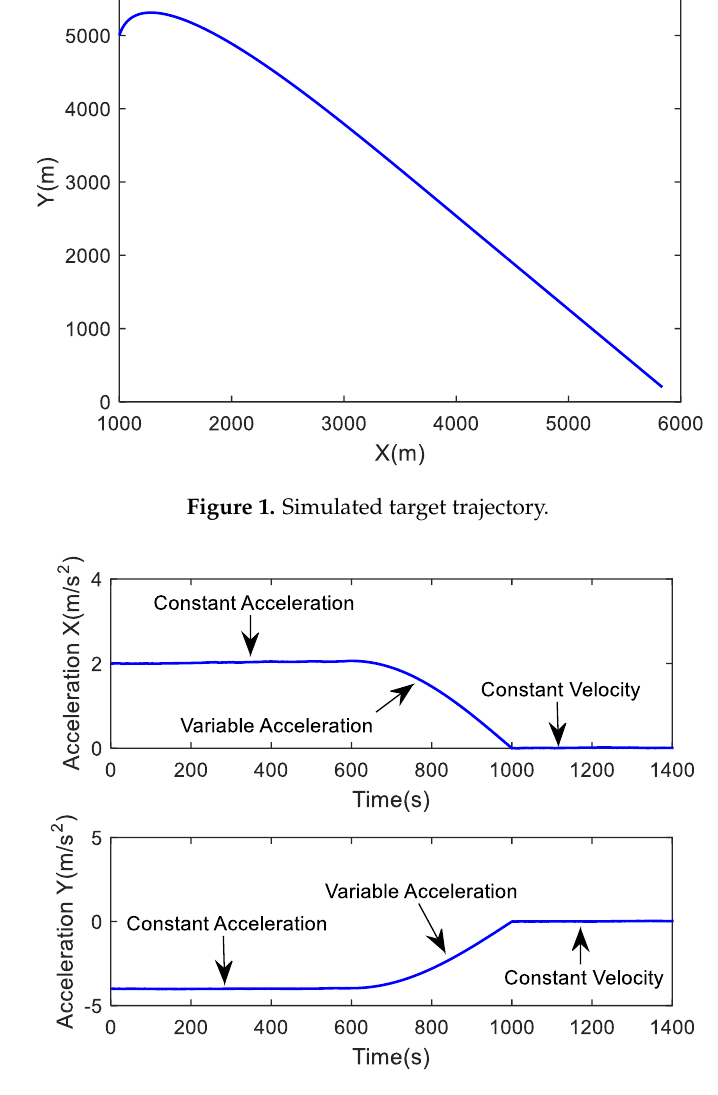
Figure 2. Actual curves of the acceleration.